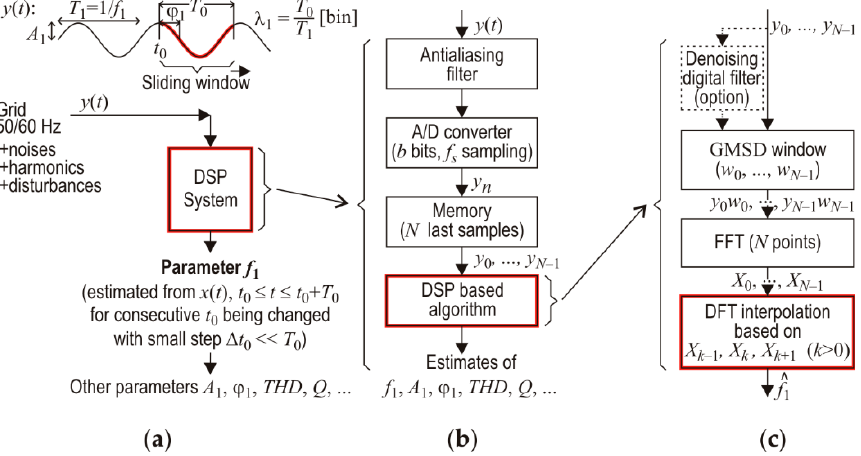
Figure 1. The real-time grid-monitoring system with a sliding time window: ( a ) the general system scheme with the definition of the sliding window; ( b ) the DSP block diagram; ( c ) the algorithm to estimate the fundamental frequency f 1 of the grid signal y ( t ).